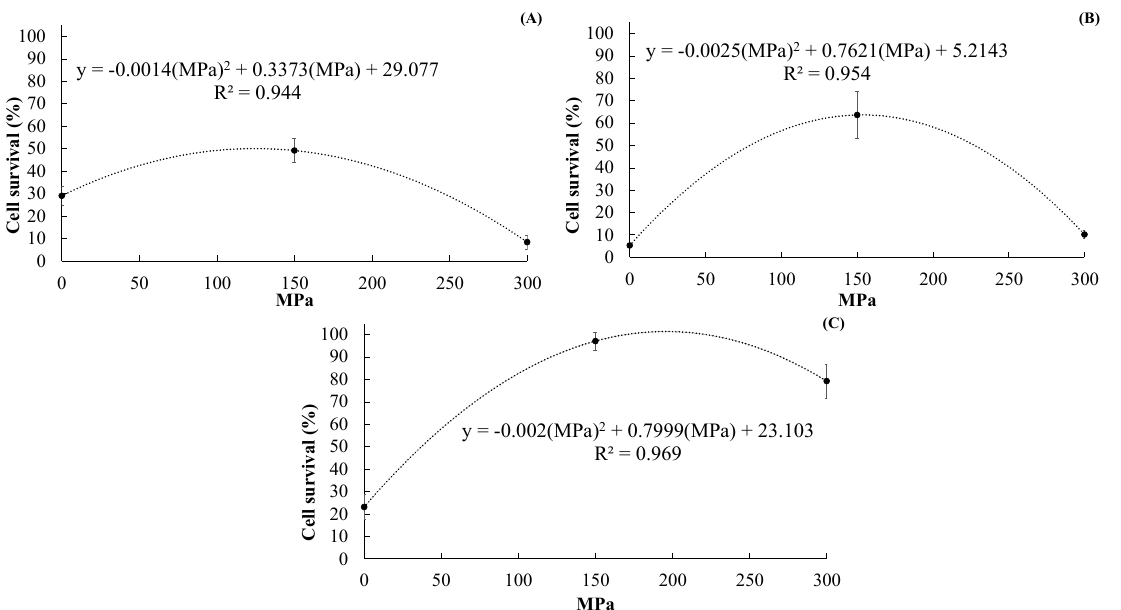
Figure 1. Cell survival (%) of L. plantarum NRRL B-1927 microencapsulated with non-UHPH-treated,